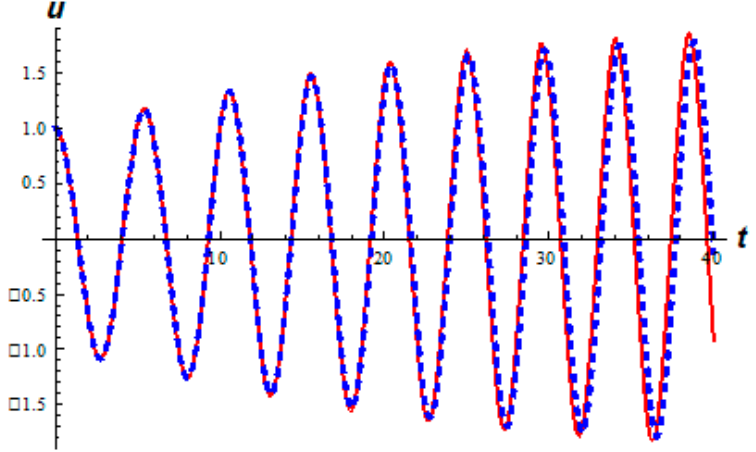
( ) Figure 6. Plots of approximate solution W n ( t ) (see Equation (15) using the modified decomposition W t (see Equation (15) using the modified decomposition Figure 6. Plots of approximate solution n method (red solid line) and RK4 method (blue dashed line) for 0 ≤ t ≤ 30 and step-size h = method (red solid line) and RK4 method (blue dashed line) for 0 30 t ≤ ≤ and step-size 0.5 h = .